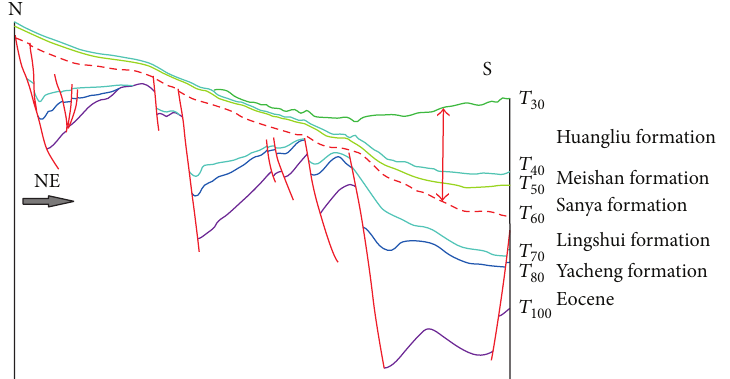
Figure 9: Seismic profile across Yabei, Yanan, and Ledong Sags in the west of the Qiongdongnan Basin. The position of the three sags is showed in Figure 1.